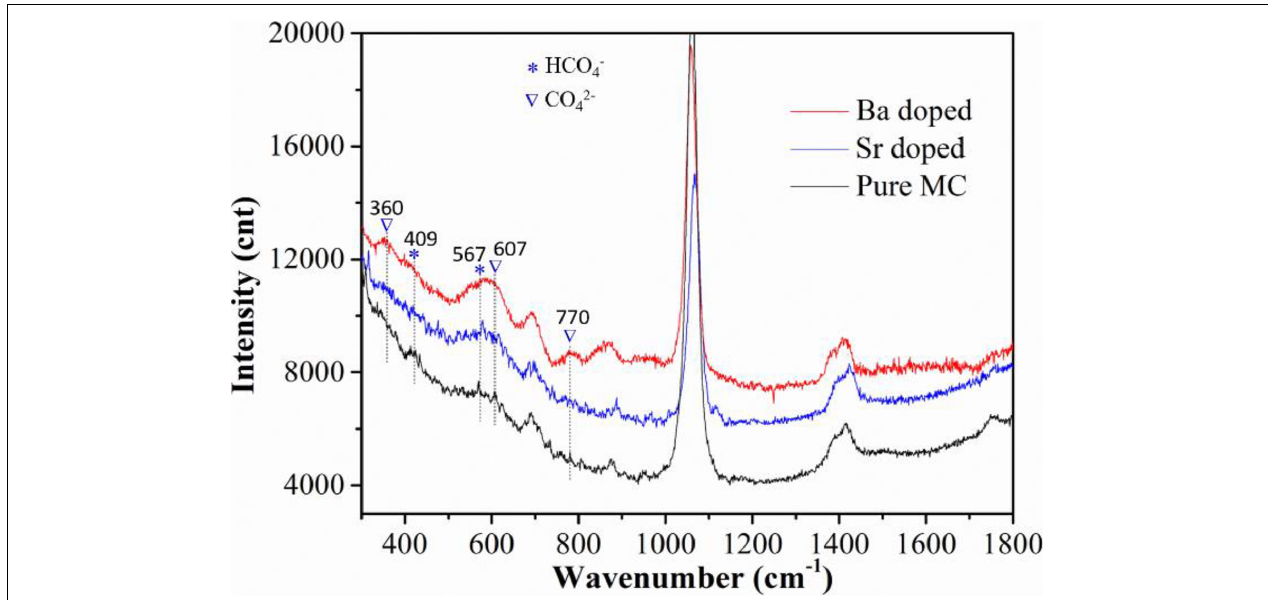
FIGURE 4 | Comparison of Raman spectra of three types of Li-Na MC (Ba-MC, Sr-MC, and MC) exposed to 45% CO 2 -10% O 2 -10% H 2 O-N 2 atmosphere at 625 ◦ C.